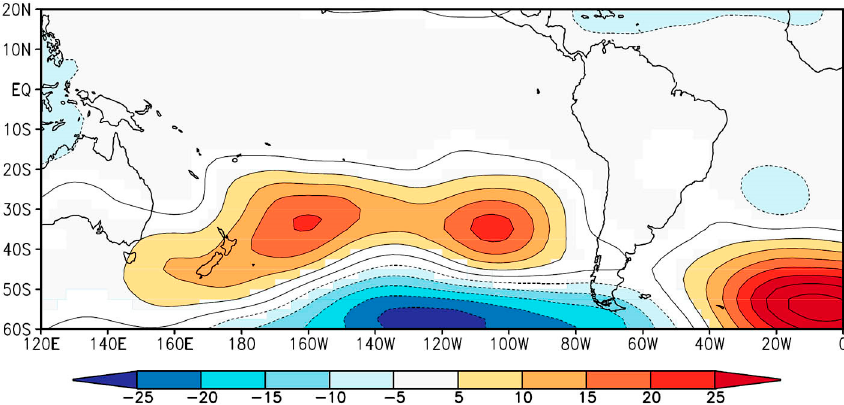
Figure 11. Composite of Z500 (NCEP/NCAR Reanalysis, [47]) anomalies (1989–2014) during the months showing more than 70% of the stations with hydrological drought conditions. Color areas are significant at the 95% significance level.